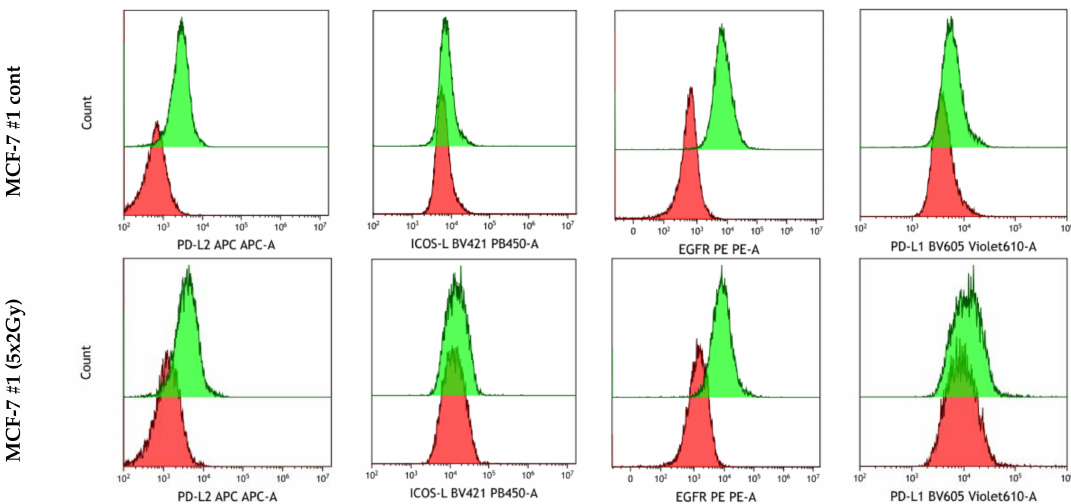
Figure A4. Fluorescence intensity (FI) peak of each fluorochrome of Panel#1 for untreated (cont., d5) and irradiated (5 × 2 Gy, d5) MCF-7 cells.